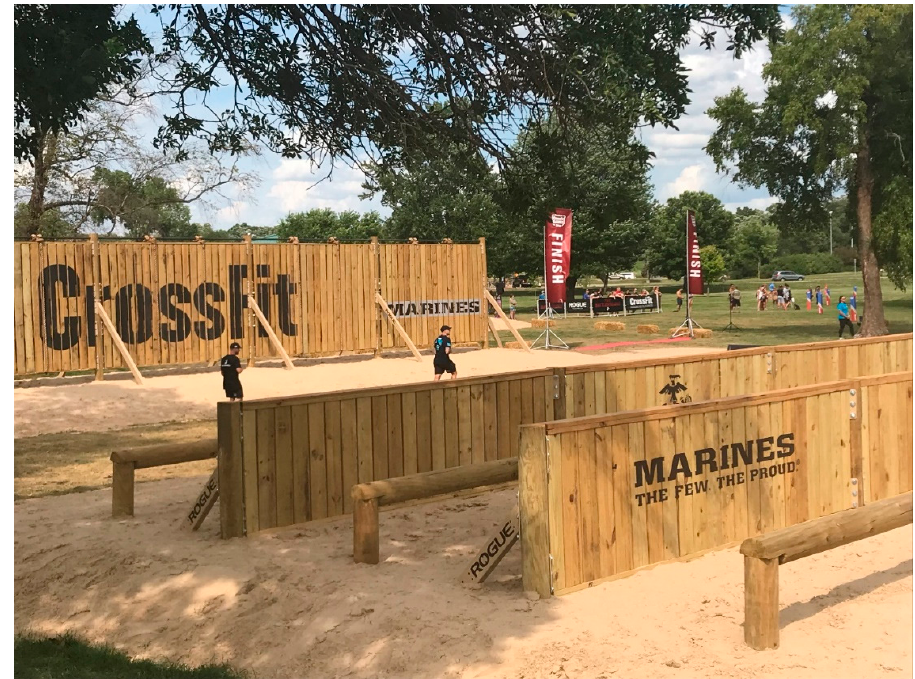
Figure 1. The Marines sponsored an event and recruited at the 2018 CrossFit Games. Photo by author.